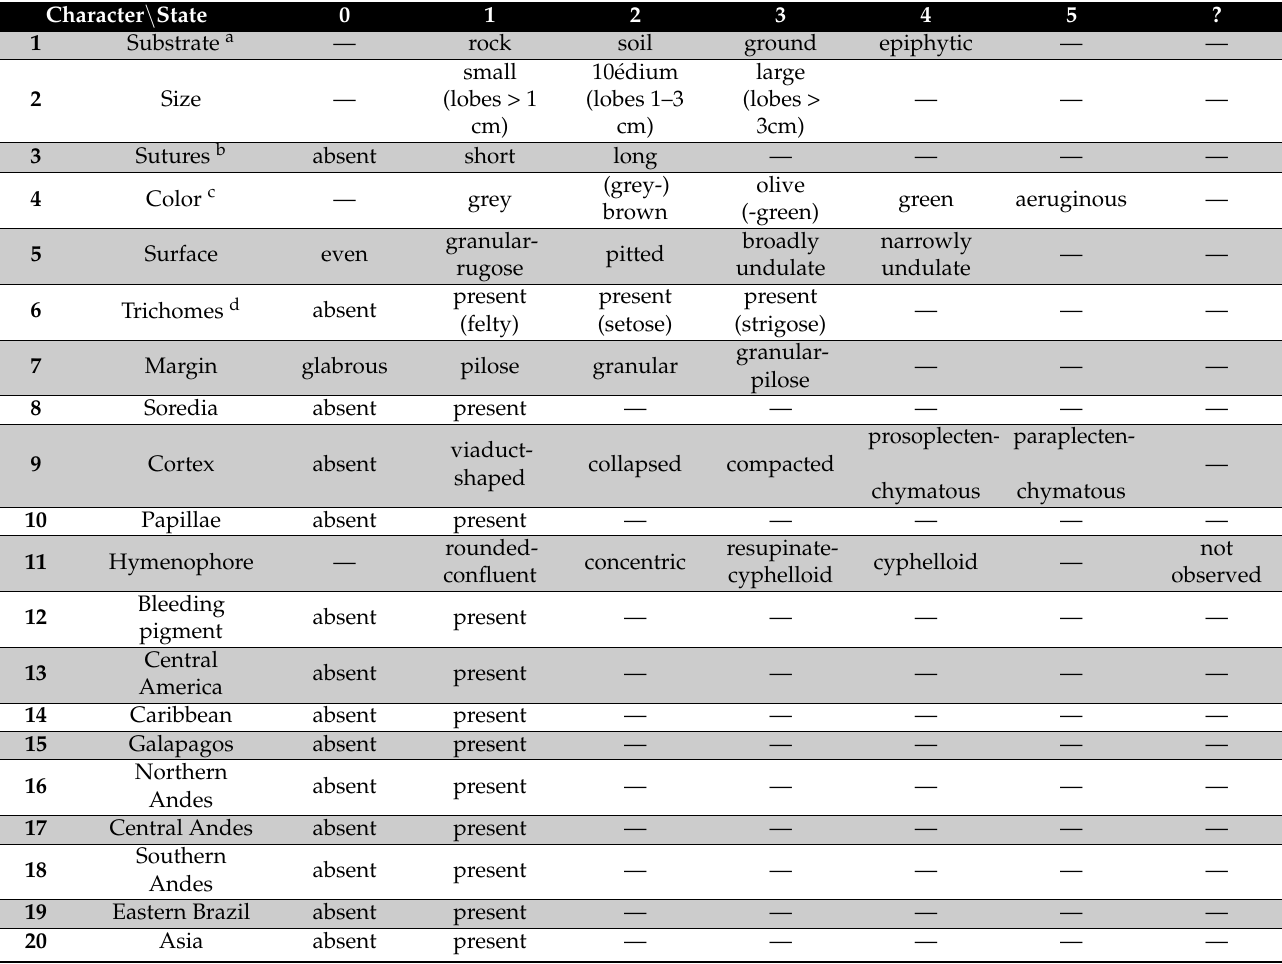
Table 1. Ecological (1), phenotypical (11), and chorological (8) characters and states scored for the selected 87 species in the genus Cora (plus two Corella ). Only the 11 phenotypical characters (Size through Bleeding pigment) were utilized for generating the character